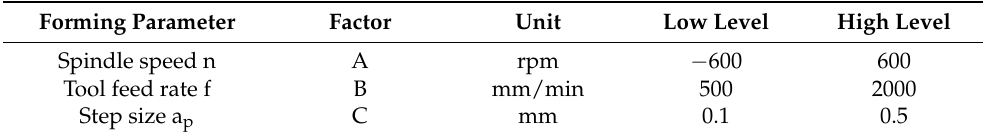
Table 2. Factors and levels used in the CCD.